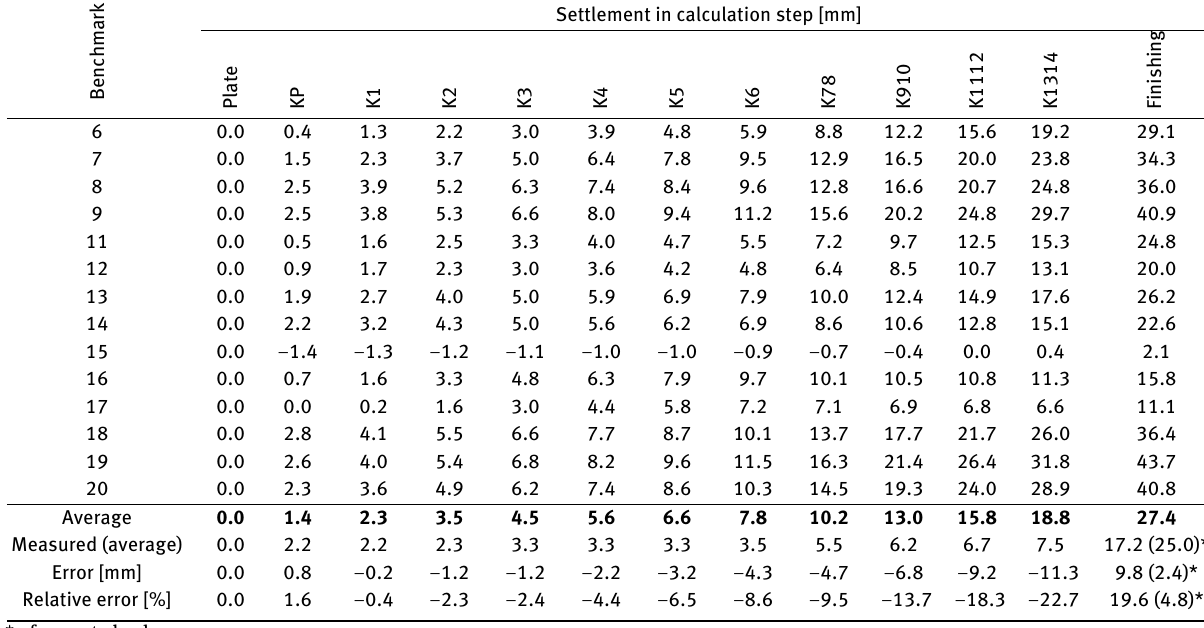
Table 2: A summary of vertical displacements in the successive calculation steps